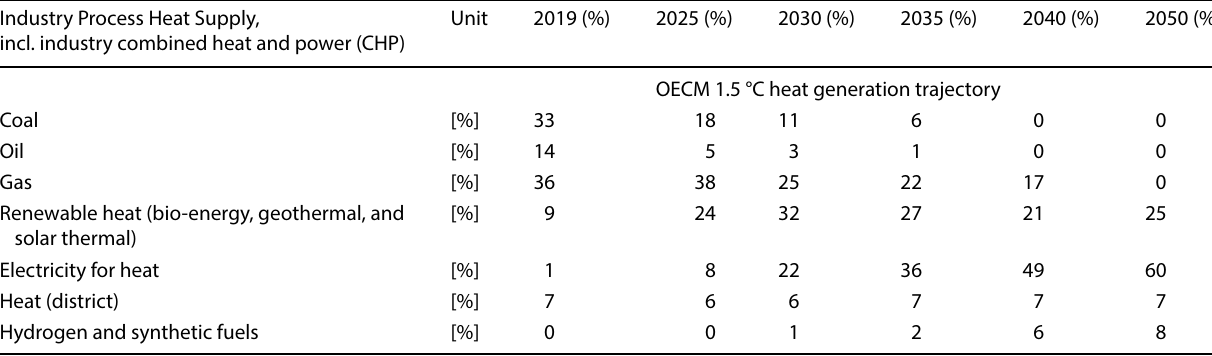
Table 14 Results: Heat supply under the OECM 1.5 °C